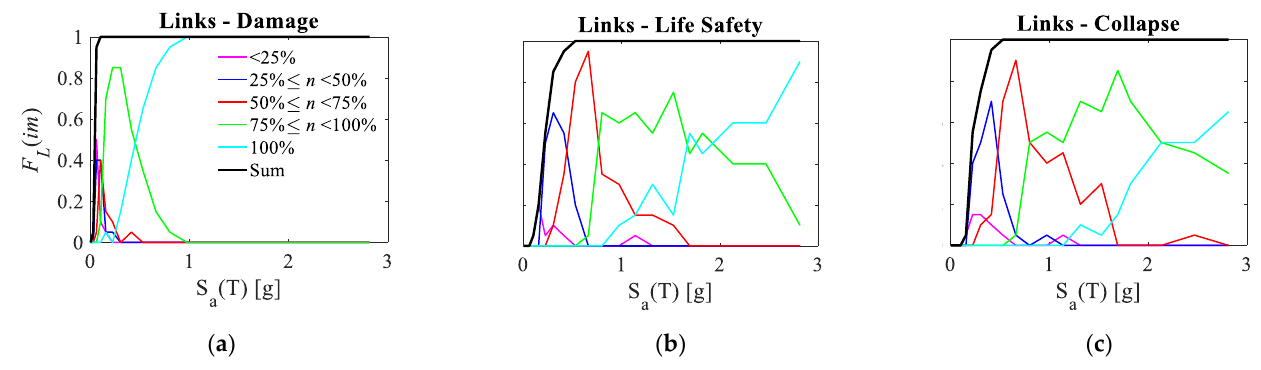
Figure 13. Type 1 quantitative fragility functions for link-slab bars: probabilities of occurrence of damage mechanisms for different percentages of involved links at ( a ) damage; ( b ) life safety; and ( c ) collapse performance levels.